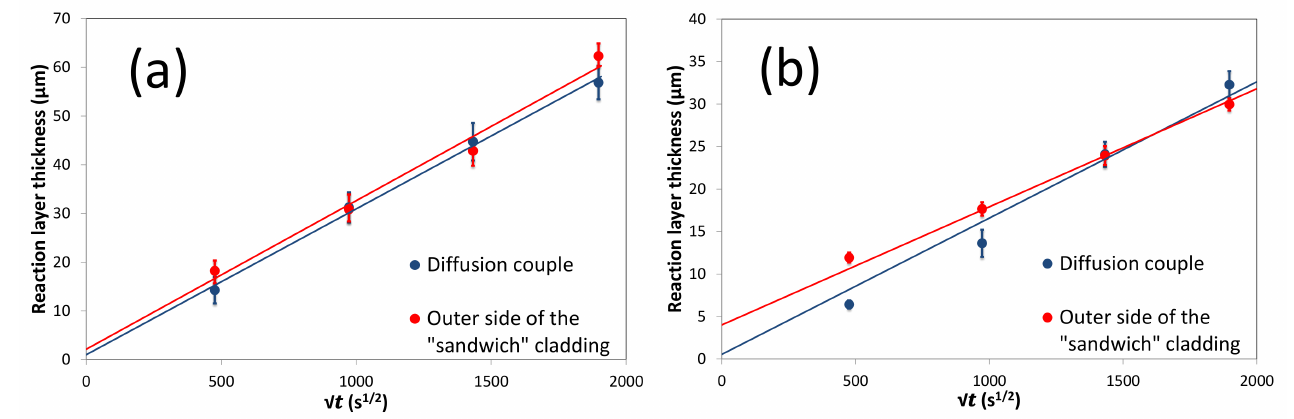
Figure 14. Evolution of the reaction zone thickness at 1200 ◦ C as a function of the square root of time and geometry in the ( a ) Nb/SiC and ( b ) Ta/SiC.